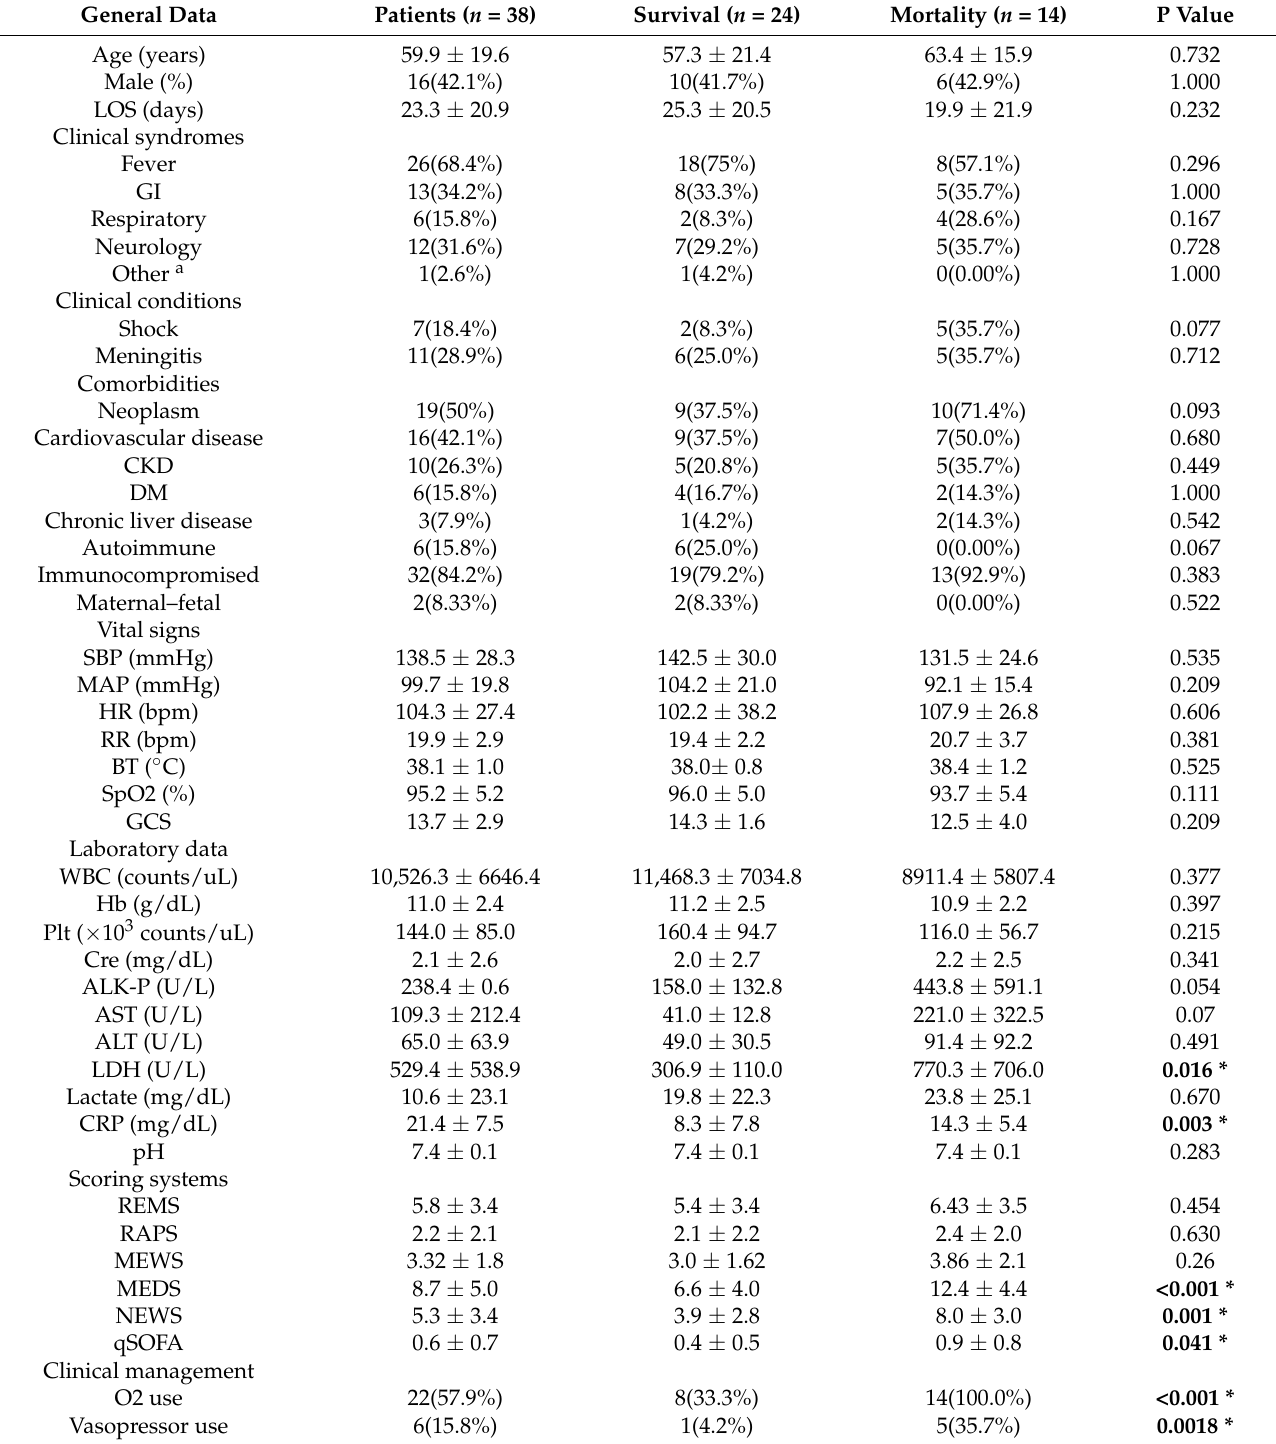
Table 1. Demographics and laboratory data of 38 patients with Listeria monocytogenes